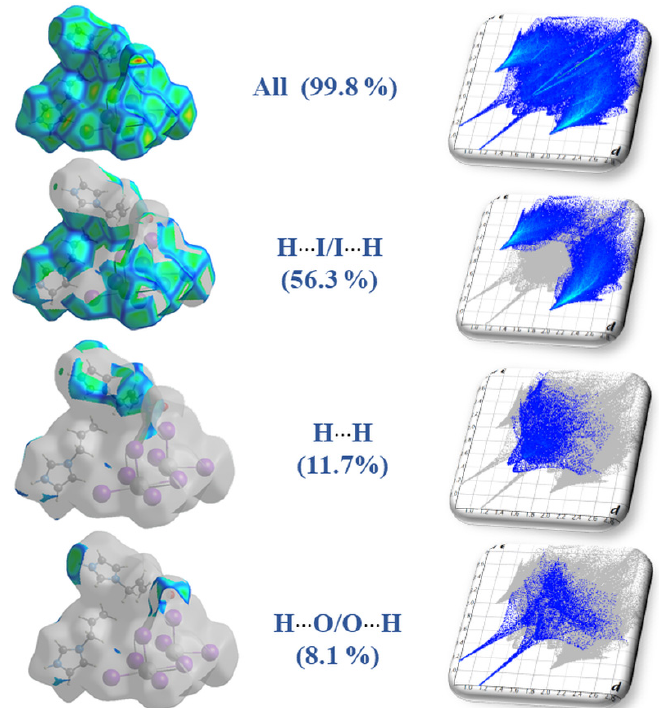
Figure 5. d norm mapped on Hirshfeld surfaces for visualizing the intermolecular interactions, d e , d i ,